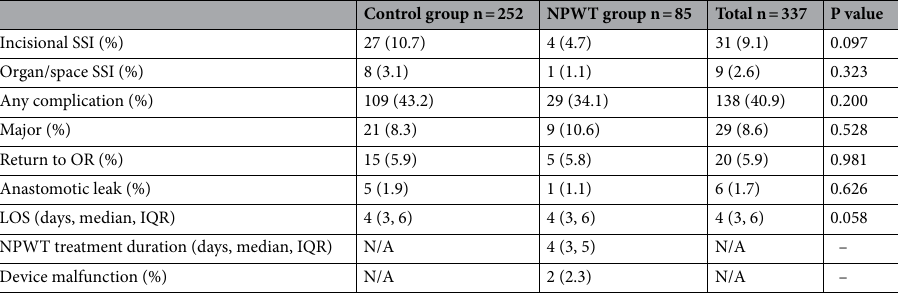
Table 2. Postoperative outcomes. Primary and secondary outcomes of patients before and after implementation of NPWT wound device. SSI—surgical site infection, OR—operating room, LOS-Length of stay, IQR—Interquartile range, NPWT—negative pressure wound